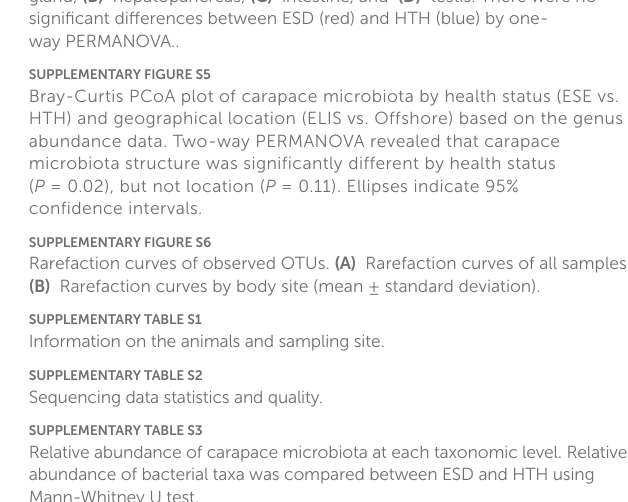
SUPPLEMENTARY FIGURE S5 Bray-Curtis PCoA plot of carapace microbiota by health status (ESE vs. HTH) and geographical location (ELIS vs. Offshore) based on the genus abundance data. Two-way PERMANOVA revealed that carapace microbiota structure was significantly different by health status ( P = 0.02), but not location ( P = 0.11). Ellipses indicate 95% confidence intervals.